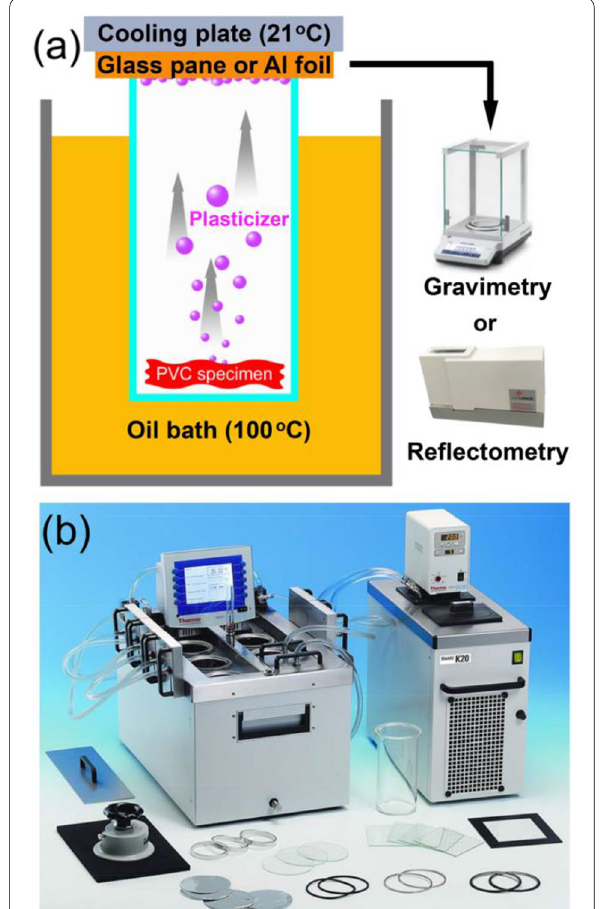
volatilization from PVC synthetic